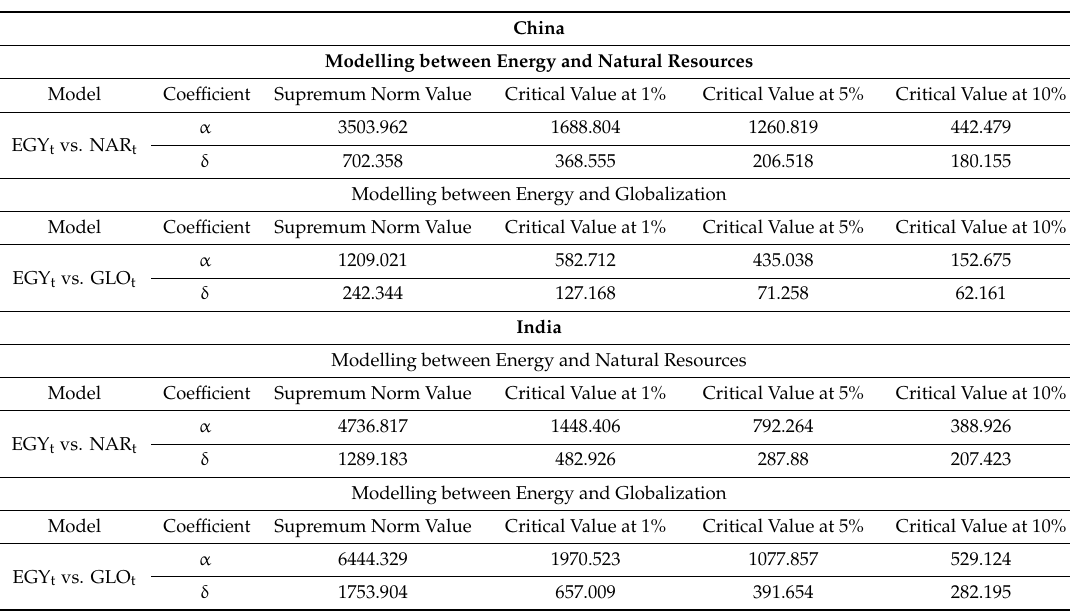
Table 4. Results of the quantile cointegration